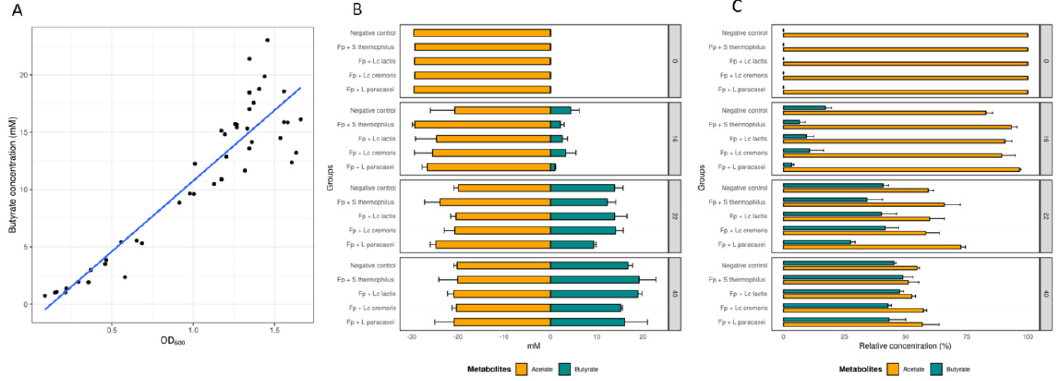
Figure 2. Acetate and butyrate levels of cultures of F. prausnitzii exposed to cell-free supernatants. ( A ) Correlation of butyrate production and growth over time (R 2 = 0.8664, p = 2.2 × 10 − 16 ). ( B ) Acetate consumption and butyrate production (concentrations in mM) and ( C ) proportion at 16, 22, and 40 h of incubation. Measurements were performed for three replicates; the mean and SD are shown.